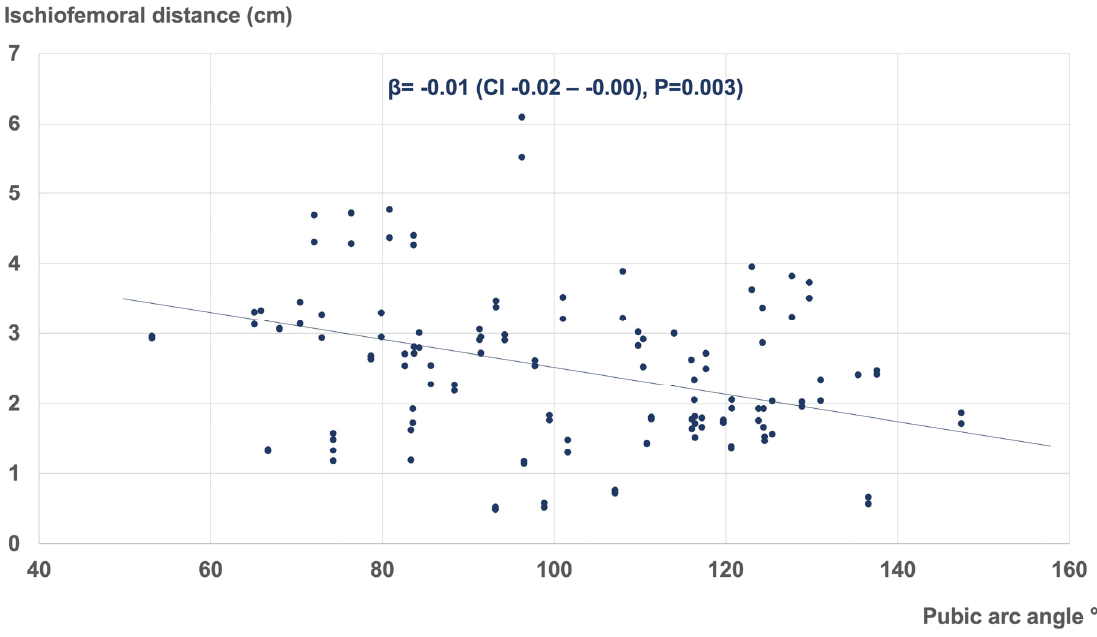
Figure 5. Linear regression demonstrating the association between the pubic-arc angle and the ischiofemoral distance (R 2 = 0.82).